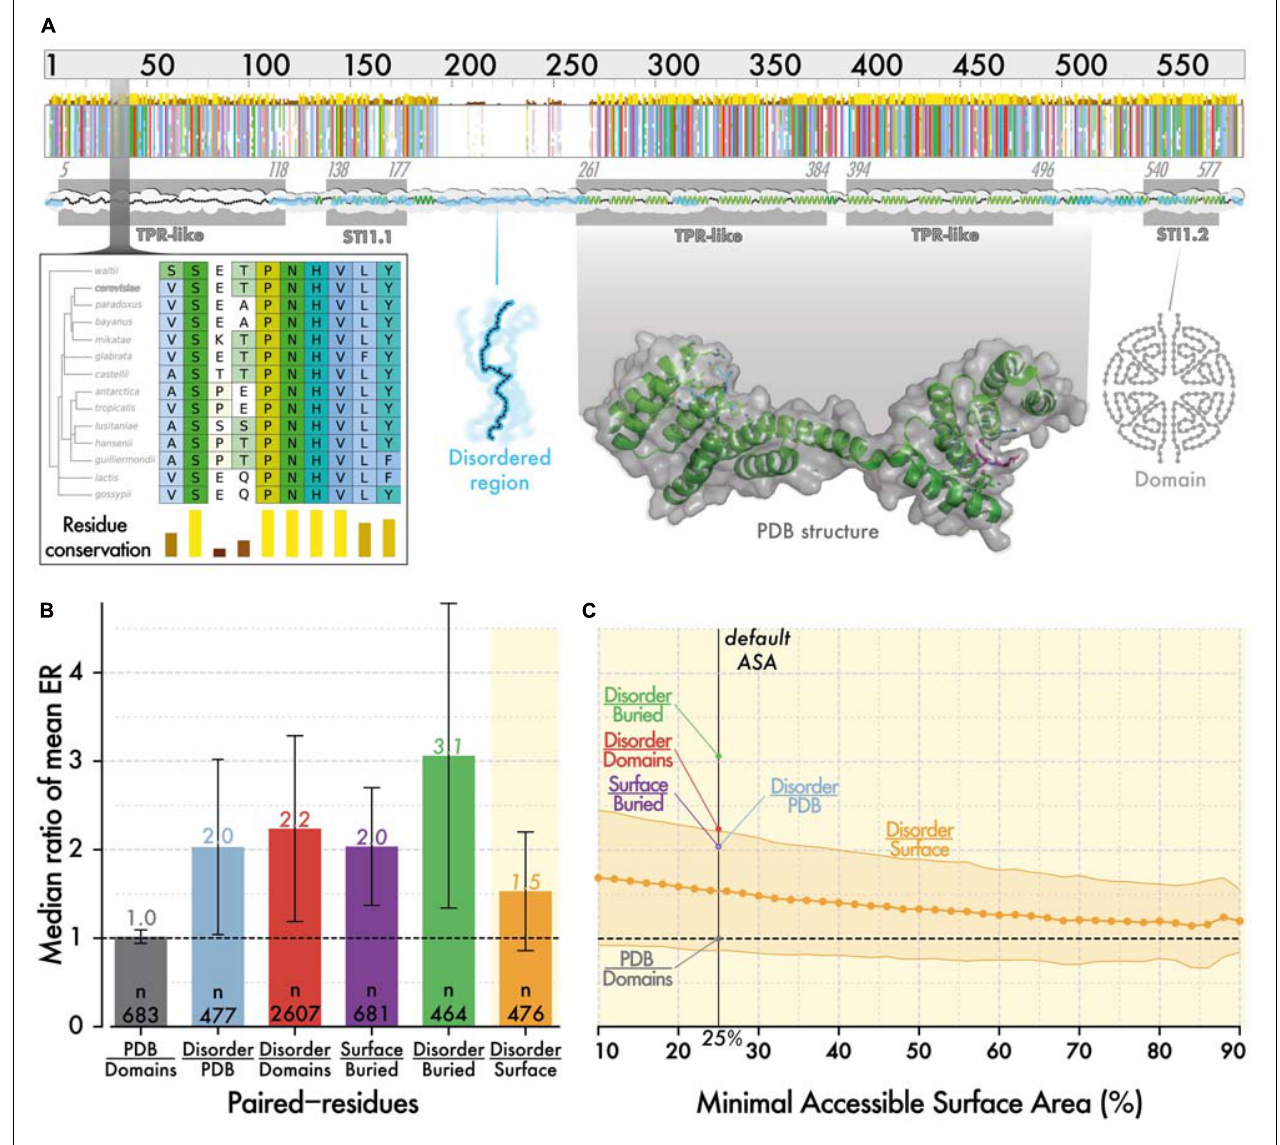
FIGURE 1 | The evolutionary rate of disordered regions is comparable to that of super-exposed regions in folded proteins. (A) Evolutionary information and structural features are mapped onto protein sequences from S. cerevisiae . The minimap represents the multiple sequence alignment of orthologous sequences to STI1. The amino acids are colored using CLUSTAL’s color scale (Thompson et al., 1994) depending on residue type and conservation. The zoomed-in panel illustrates residue-level conservation, which we calculated with Rate4Site (Pupko et al., 2002). We mapped the positions of PFAM (Bateman et al., 2002) and SUPERFAMILY (Gough and Chothia, 2002) domains (gray box), and of disordered regions predicted by IUPRED (Dosztányi, 2018) (cyan ribbon). We also mapped structural information available from PDB (Rose et al., 2017; Armstrong et al., 2019) and 3DComplex (Levy et al., 2006) on sequences. For this particular sequence, structural information was partially available based on PDB code 3UQ3 (Schmid et al., 2012). (B) Within proteins, the evolutionary rate of residues in different regions are averaged, and we compare the ratio of these averages. We show the median of ratios with error bars corresponding to the median absolute deviation. Surface and buried residues are defined based on relative ASA of > 25 and ≤ 25%, respectively (Levy, 2010). (C) We calculate the same ratio as in panel (B) , between disordered regions and surface regions, using an increasingly stringent relative ASA cut-off to define surface residues. As we increase the cutoff, the median ratio tends toward 1, which highlights that disordered residues evolve only slightly faster than the most exposed residues at protein